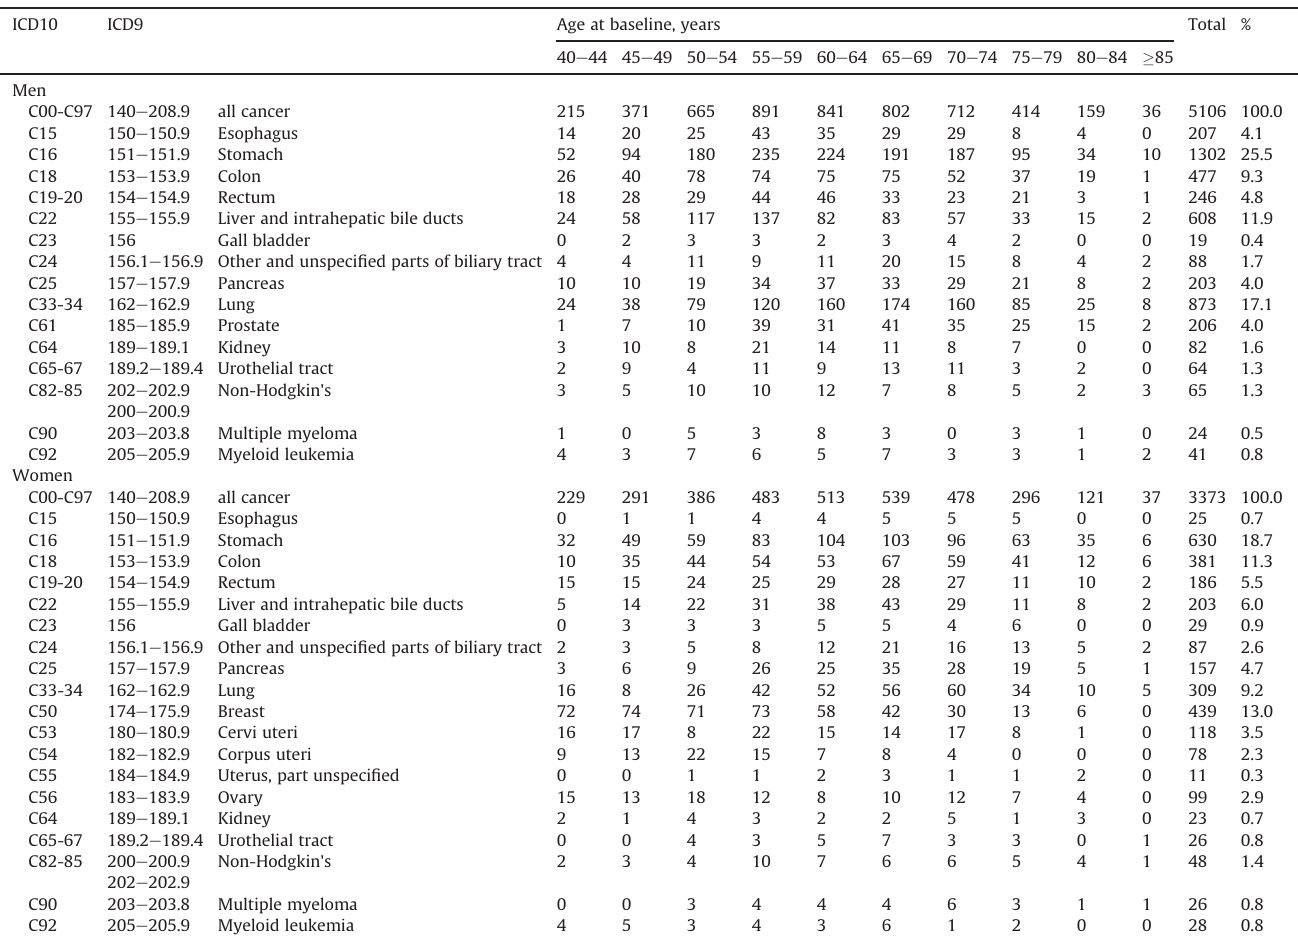
Table 5 Distribution of number of cancer incidence by site, gender, and age at baseline during 15-year follow-up.